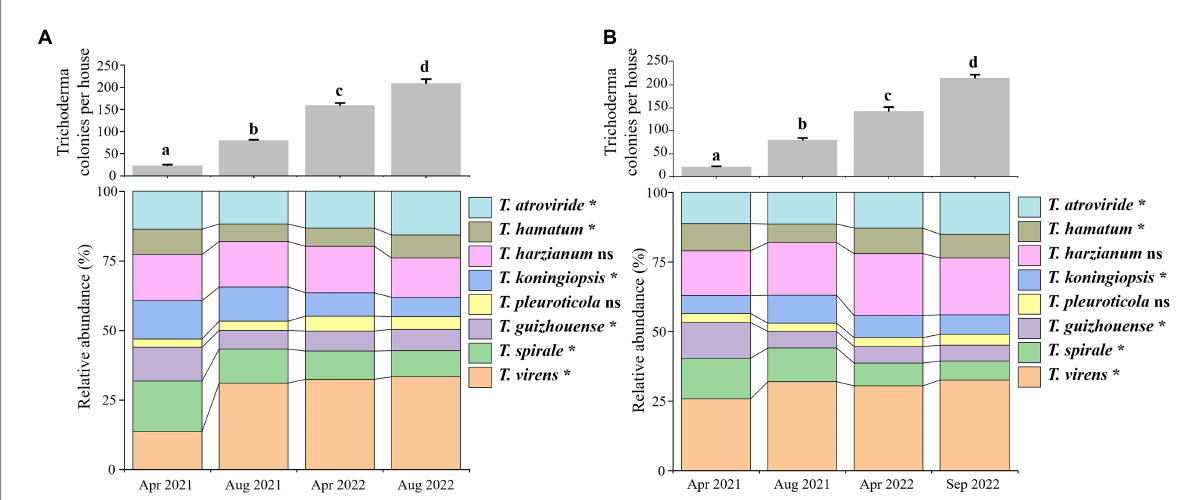
FIGURE 3 Population changes of Trichoderma spp. on the soil surface of Ganoderma lucidum cultivation houses in Lanju (A) and Chengbei (B) trails. The bar graphs show the increase in the colony number of all Trichoderma species on the soil surface per house. Data were the average number of Trichoderma colonies in six mushroom houses. Means in the plot topped by the different letters indicate the significant difference based on Duncan’s multiple range test of one-way ANOVA at p < 0.05. The lower panels show the taxonomic composition of Trichoderma communities in the different investigation periods at the species level. ns, not significant at p < 0.05; asterisk indicates significance at p < 0.05 based on Games– Howell post-hoc test and Benjamini–Hochberg false discovery rate (FDR) as the multiple test correction